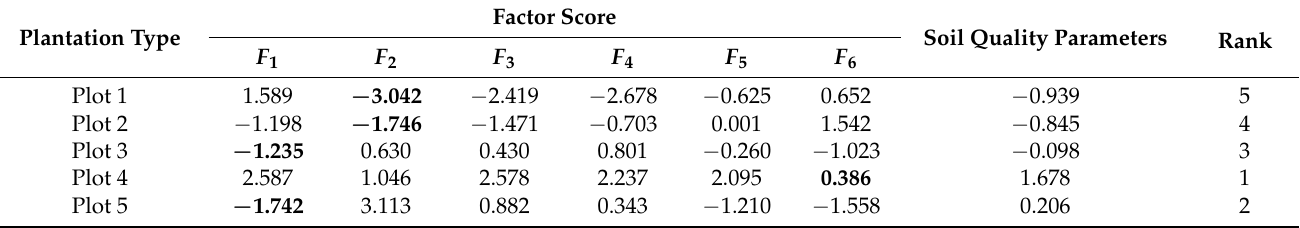
Table 5. Soil quality evaluation of Z. planispinum plantations with different planting